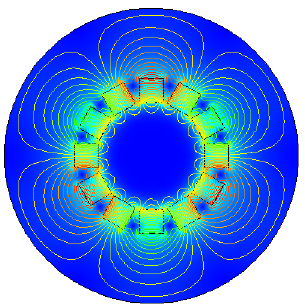
Figure 2. Halbach array magnetic field distribution diagram.